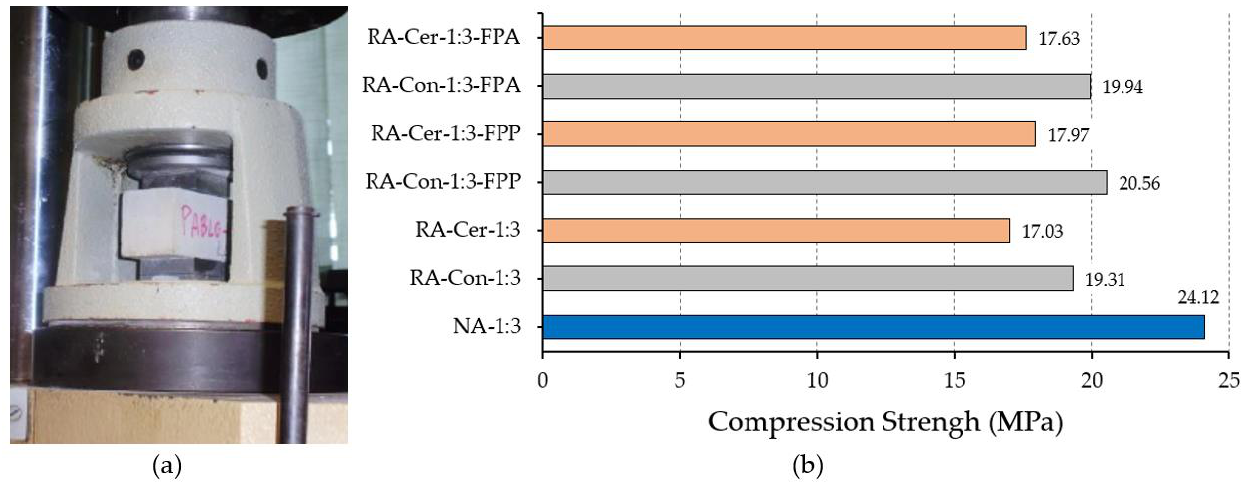
Figure 4. ( a ) Compressive strength test; ( b ) compressive strength test results.